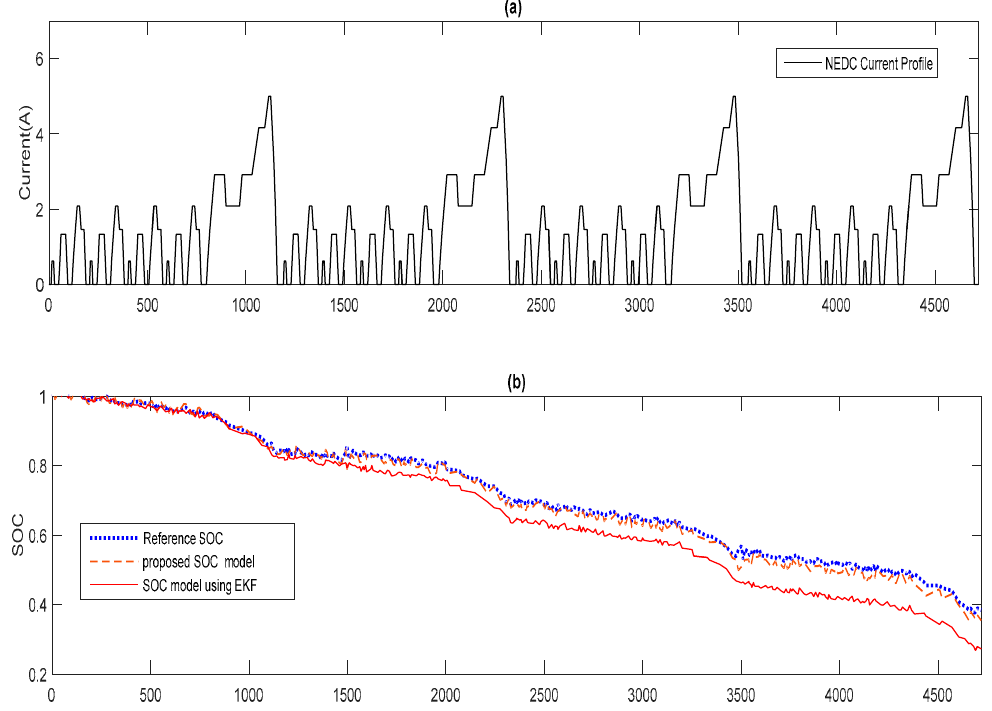
Figure 14. ( a ) New European Driving Cycle (NEDC) current profile; ( b ) SOC comparison with EKF-based model.